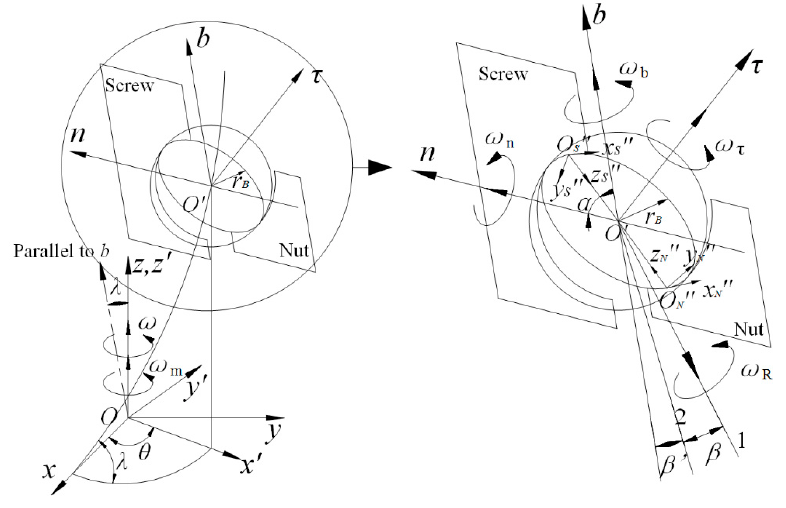
Figure 2. Coordinate systems.